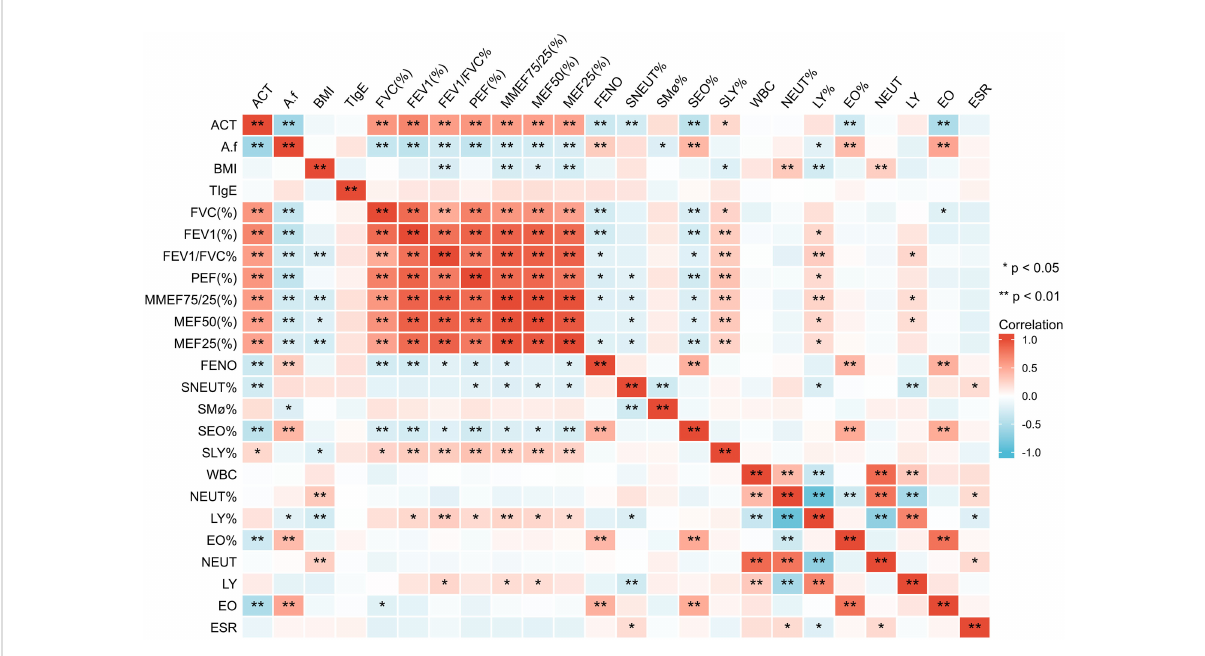
FIGURE 3 Correlation of clinical parameters in all the patients. ACT, asthma control test; A.f , Aspergillus fumigatus ; BMI, body mass index; tIgE, total IgE; FVC, forced vital capacity; FEV1, forced expiratory volume in 1 s; PEF, peak expiratory fl ow; MMEF, maximum mid-expiratory fl ow; MEF50, maximal expiratory fl ow 50; MEF25, maximal expiratory fl ow 25; FeNO, fractional exhaled nitric oxide; SNEUT, sputum neutrophils; SMø, sputum macrophages; SEO, sputum eosinophils; SLY, sputum lymphocytes; WBC, white blood cell; NEUT, neutrophils; LY, lymphocytes; EO, eosinophils; ESR, erythrocyte sedimentation rate; PCT, procalcitonin. *p<0.05; **p<0.01.